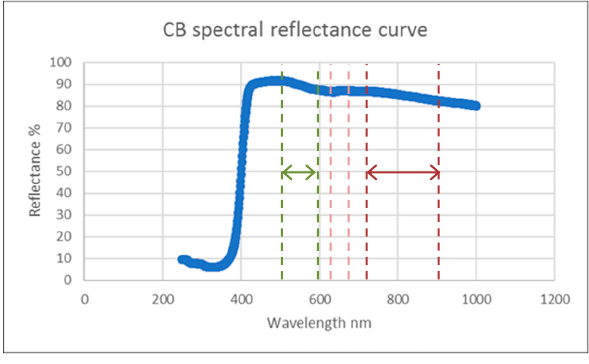
Figure 6. Calibration bracket reflectance curve 250–1000 nm at 1 nm intervals.